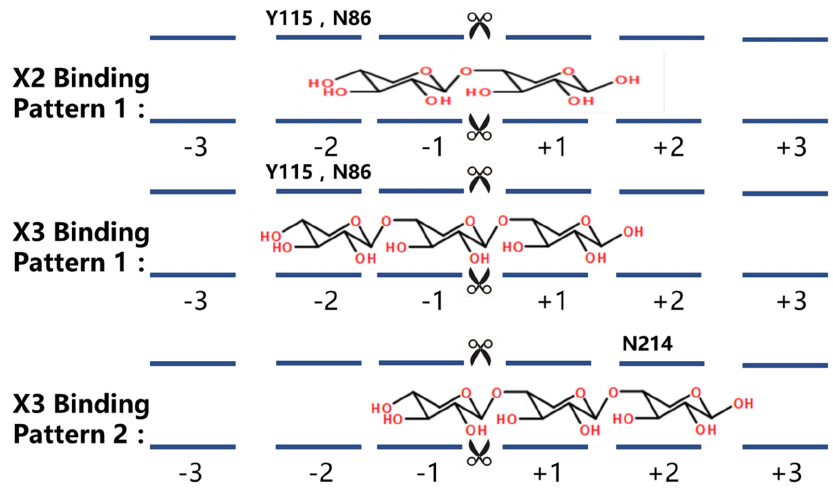
Figure 6. XOS and catalytic domain binding patterns.